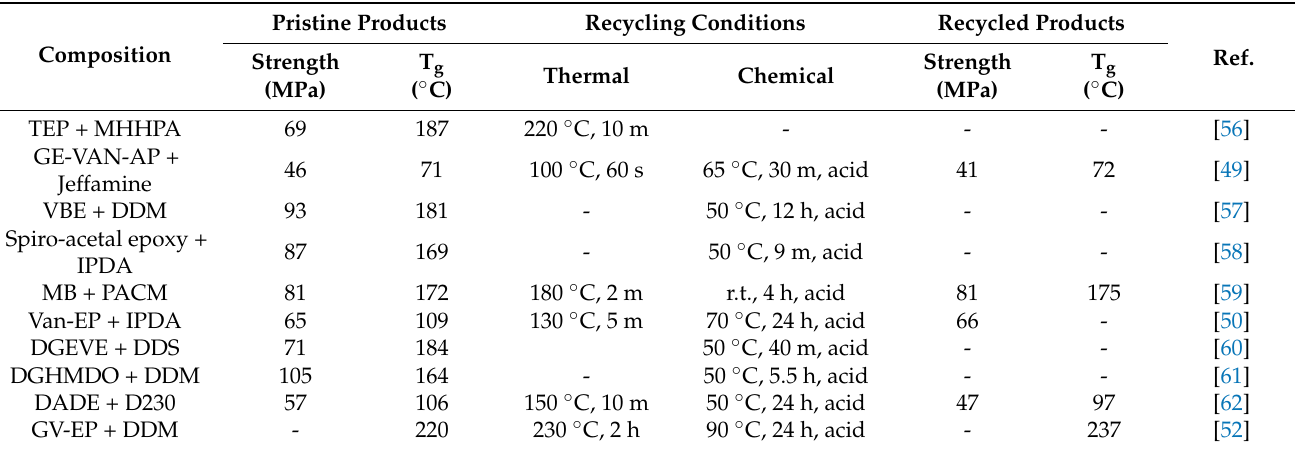
Figure 3. Potential modification of vanillin monomer to epoxy monomer. Table 1. Thermal and mechanical properties as well as recycling conditions of vanillin-modified epoxy vitrimers.